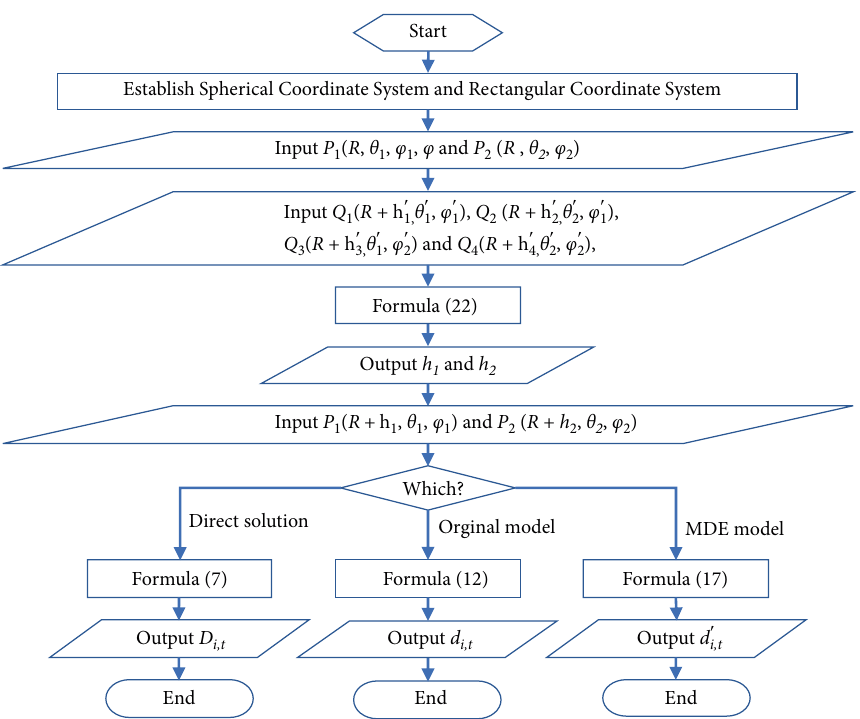
Figure 5: Flow chart of Spherical Bilinear Interpolation Model and its